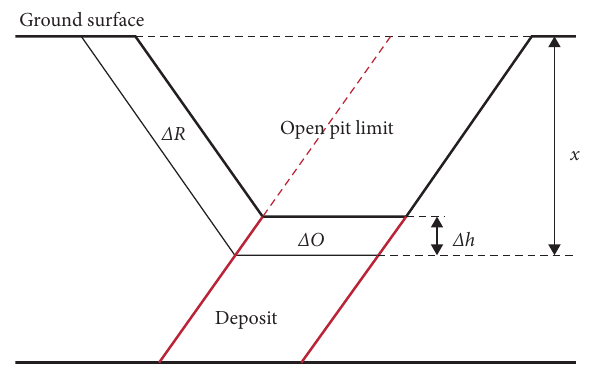
Figure 1: Schematic presentation for open-pit limit design by conventional UPL methodology.